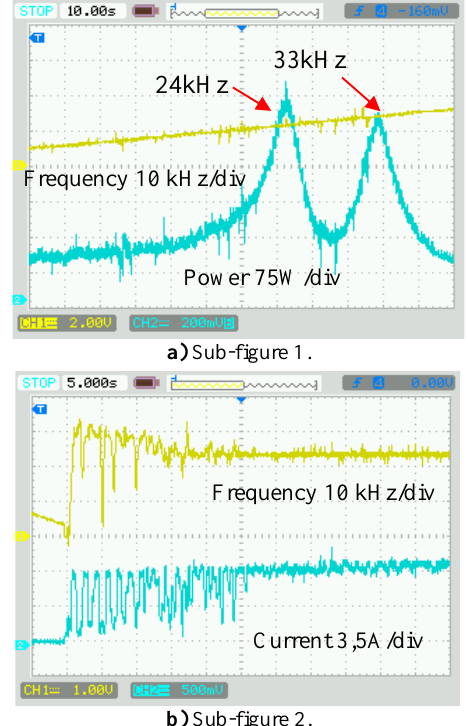
Figure 7. Oscilloscope screenshot for Scenario I for (a) scanning for input power to the primary side resonant coupler and the inverter’s switching frequency and (b) performance of PSO algorithm